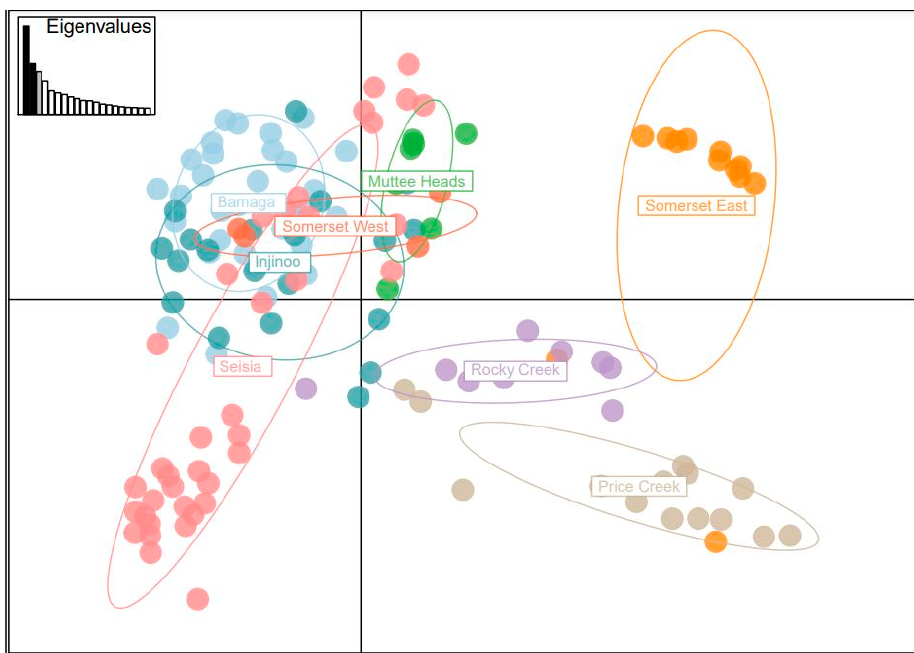
Figure 3. Principal coordinates analysis (PCoA) of eight Santalum lanceolatum populations from Cape York (Queensland, Australia) using the axes 1 and 2 of genetic distance matrices. Inset graph represents proportions of Eigenvalues at axes 1 and 2 shown in black, which explain 27.48% of variation.